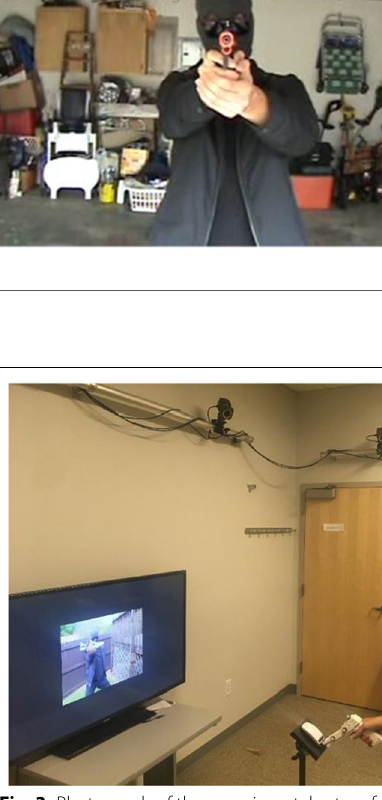
Fig. 3 Photograph of the experimental set up for the gun